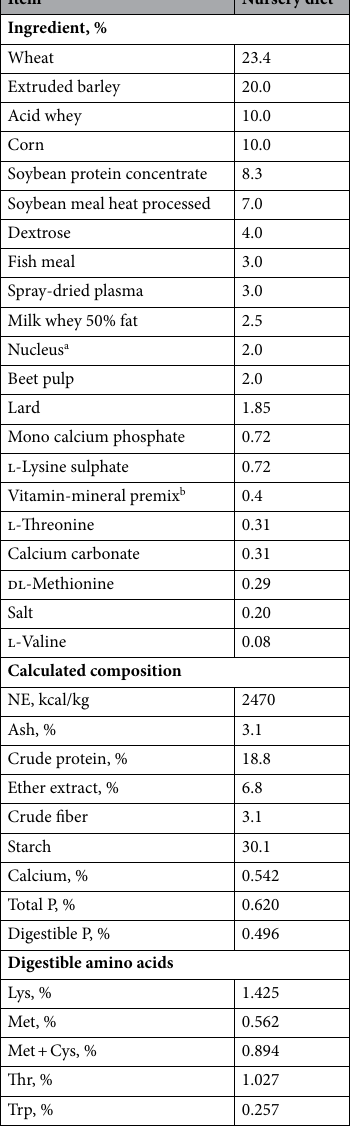
Table 4. Nursery diet offered to the animals included in the trial. a Basic composition of the nucleus: yogurt, extruded soybean, micronized carob meal, nucleotides, hyperimmune egg and endo-1,4 beta-xylanase (420 UI/kg). b Provided per kilogram of diet: 12,000 IU of vitamin A (acetate); 2000 IU of vitamin D3 (cholecalciferol); 250 IU of vitamin D (25-hydroxicholecalciferol); 75 mg of vitamin E; 2 mg of vitamin K3; 3 mg of vitamin B1; 7 mg of vitamin B2; 7.33 mg of vitamin B6; 15 mg of vitamin B12; 17 mg of d-pantothenic acid; 45 mg of niacin; 0.2 mg of biotin; 1.5 mg of folacin; 80 mg of Fe (chelate of amino acids); 100 mg of Zn (chloride); 12.5 mg Zn (chelate of amino acids); 12.5 mg of Mn (chloride); 0.3 mg of Se (inorganic); and 2.04 mg of